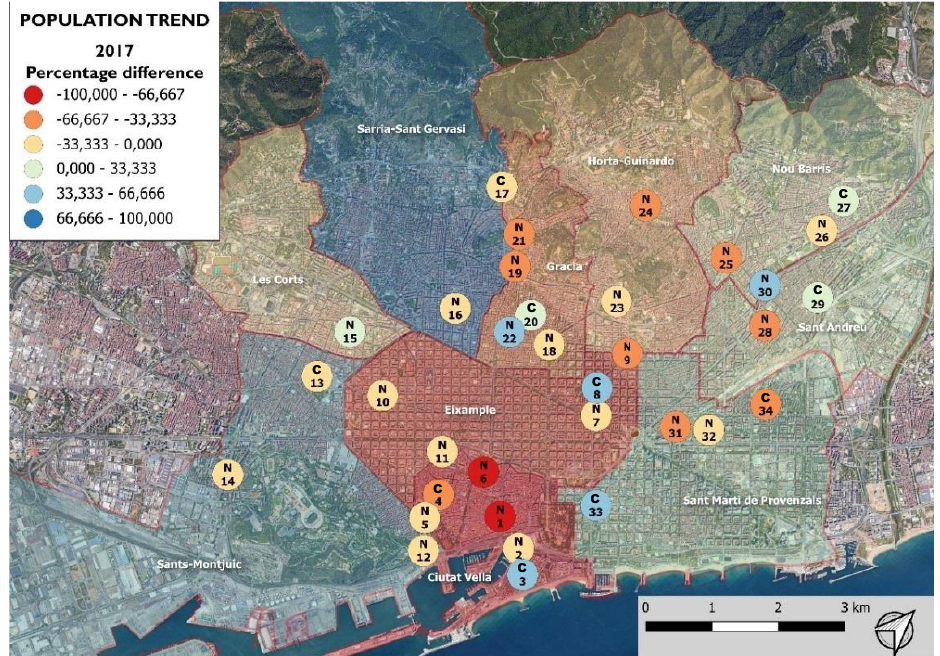
Figure 5. Heat map of the population trends registered during the 2017 superiority study (2017 pre-treatment and post-treatment periods) in the pigeon colonies included as test (N, nicarbazin) and control (P, control) groups.